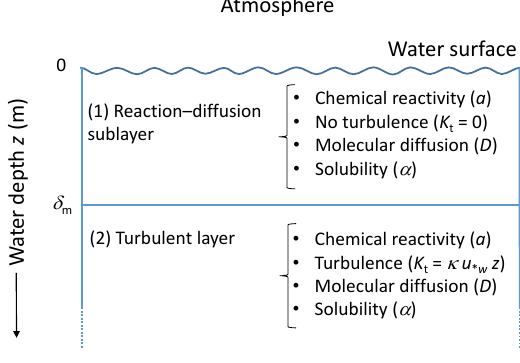
Figure 2. A simplified, two-layer structure used to represent the near-surface ocean in the model and the processes included in the calculation of ozone dry deposition to sea